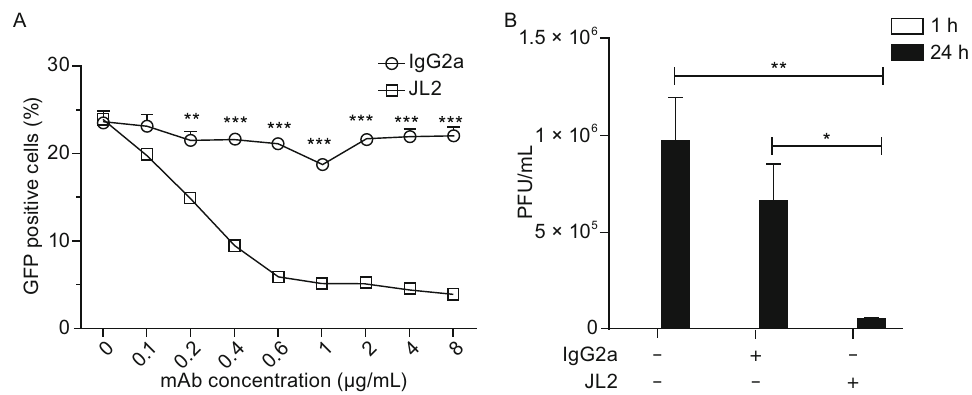
Figure 2. JL2 blocks EV71 infection. (A) GFP-positive cell counts among 293-hSCARB2 cells pretreated with JL2 (square) or the isotype control (circle) before EV71-GFP infection. The data are shown as the mean ± SEM of triplicates. (B) The replication of wild type EV71 in 293-hSCARB2 cells in the presence of JL2 (2 μ g/mL) or isotype control. The data are presented as the mean ± SEM of triplicates. * P < 0.05, ** P < 0.01, and *** P < 0.001 by Student ’ s t test.